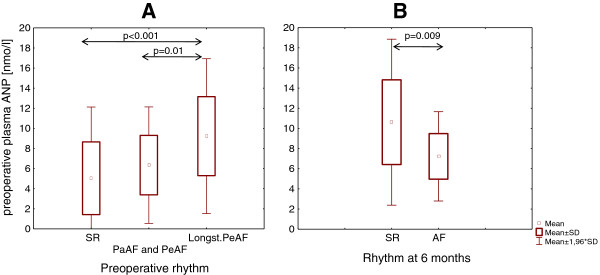
Preoperative ANP. (A) Comparison of the groups with longstanding persistent AF (Longst.Pe AF, n = 27), paroxysmal (PaAF) and persistent (PeAF) AF (n = 15) and SR control group (n = 20), (B) Comparison of individuals according to rhythm at 6 months after ablation in longstanding persistent AF. ANP: atrial natriuretic peptide.